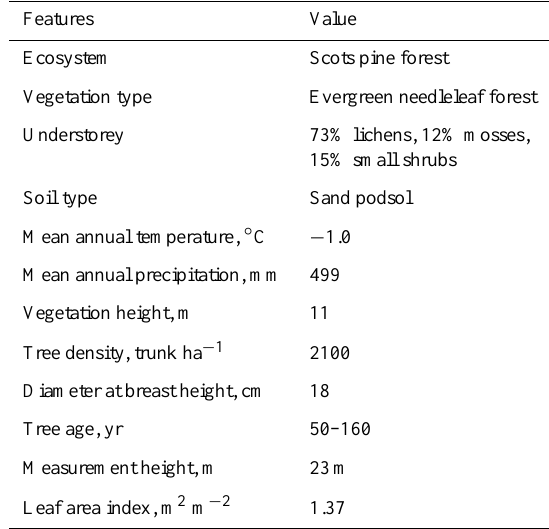
Table 1. Characteristics of the SIFLEX-2002 study